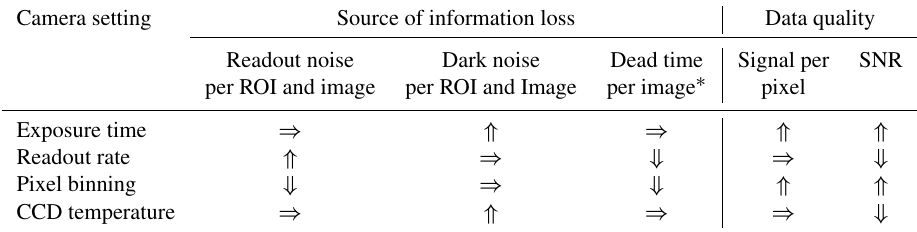
Table 2. Correlation between basic camera settings and data quality. Up arrows: increasing this parameter leads to an increase of, for example, noise, time span and intensity. Down arrow: increasing this parameter leads to a decrease of the corresponding attribute. Right arrow: changed parameter settings do not affect the attribute.